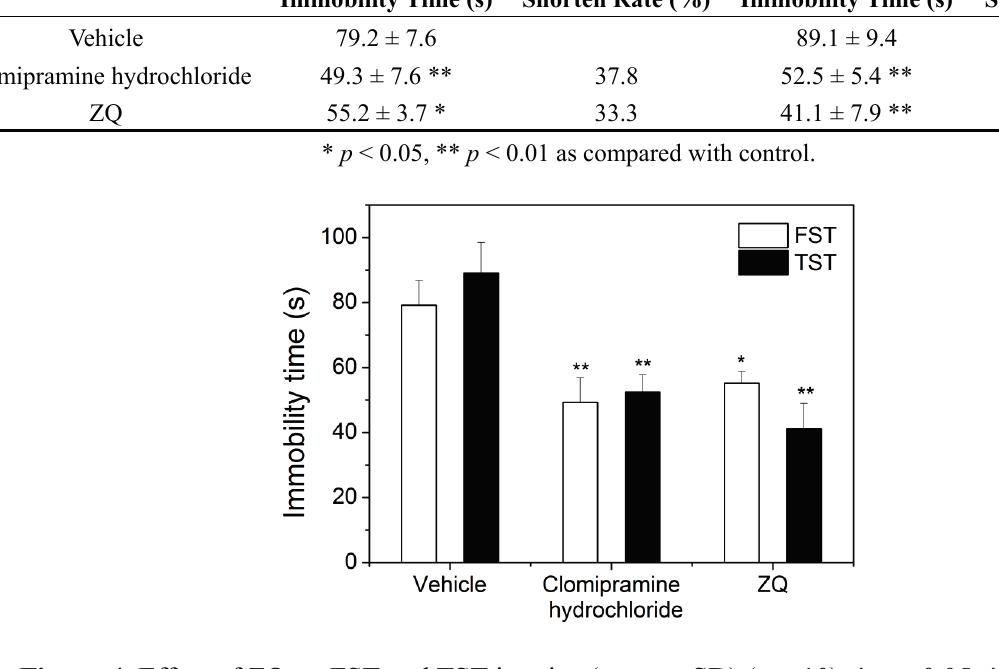
Figure 4. Effect of ZQ on FST and TST in mice (mean ± SD) ( n = 10). * p < 0.05, ** p < 0.01 as compared with